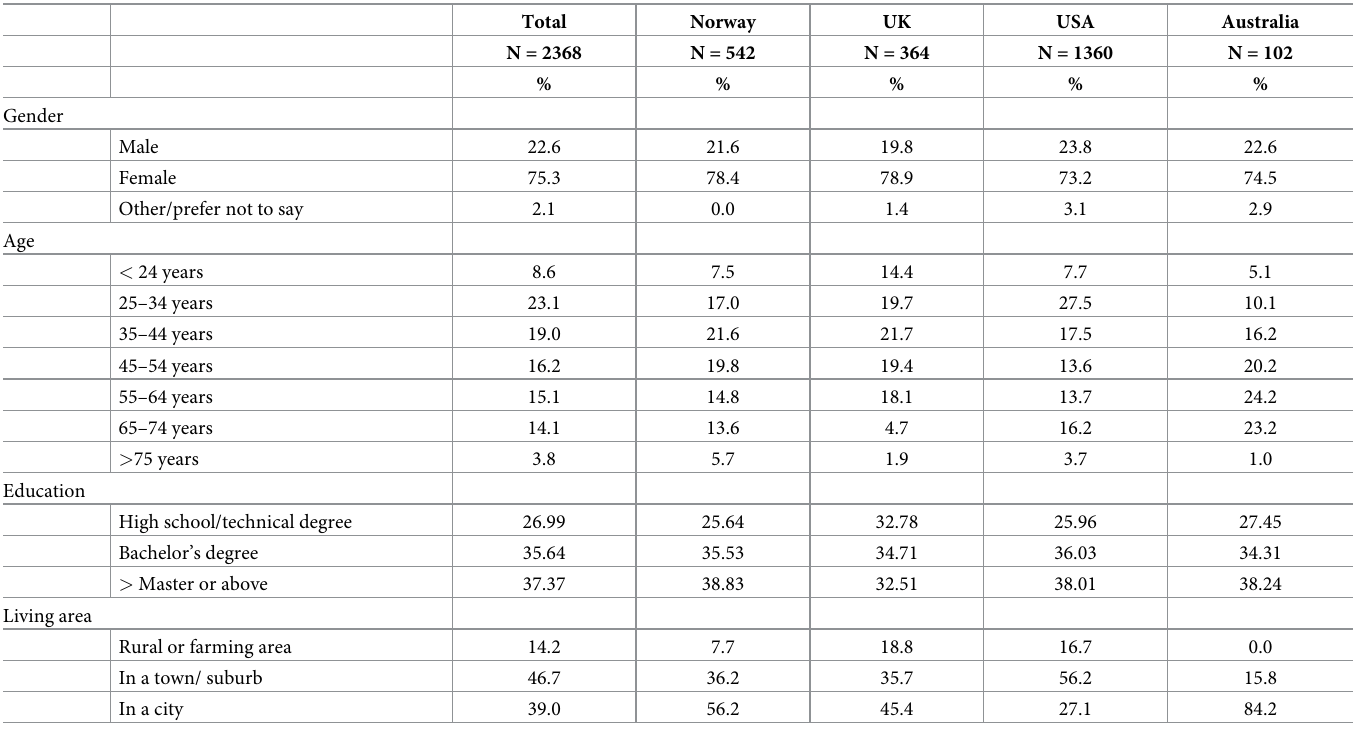
Table 1. Participant characteristics (N =